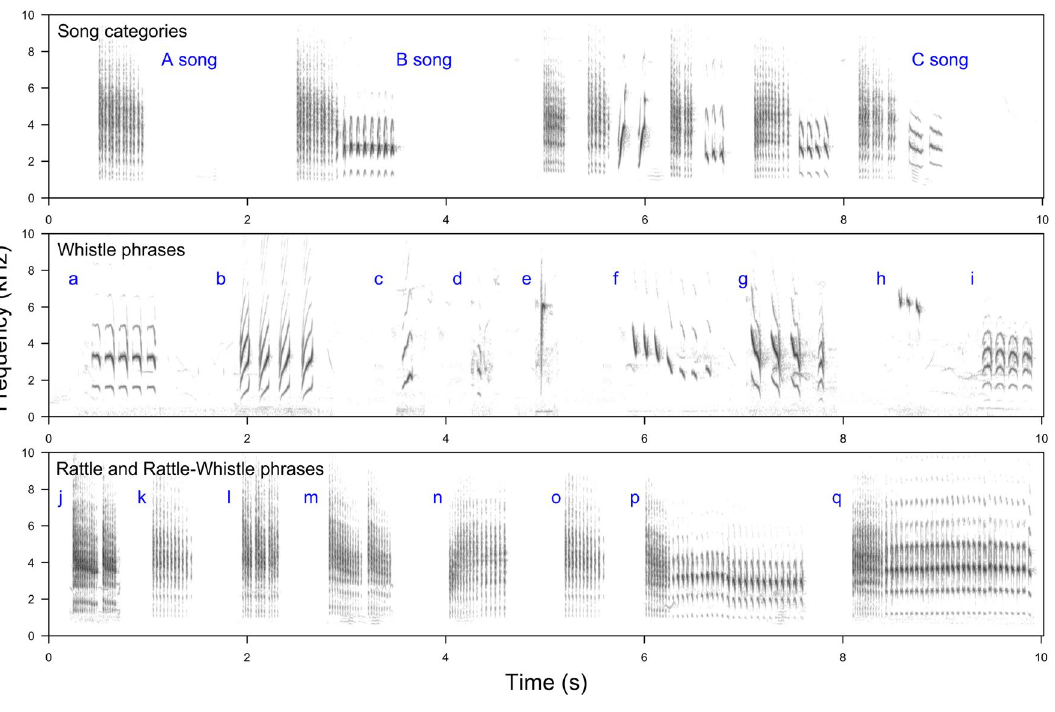
Figure 1. Sonograms illustrating variation of song of the Aquatic Warbler males. The ‘Song categories’ panel presents three basic categories of songs distinguished based on their structure: A-songs built of a single rattle phrase, B-songs built of rattles and whistles, and C-songs built of more than two rattles and whistles produced in a sequence. The ‘Whistle phrases’ panel presents the different whistles ( a – i ) which are characterised in the main text. Similarly, the ‘Rattle and Rattle–Whistle phrases’ panel presents variation of rattles ( j – o ) and mixed rattle- whistle phrases ( p , q